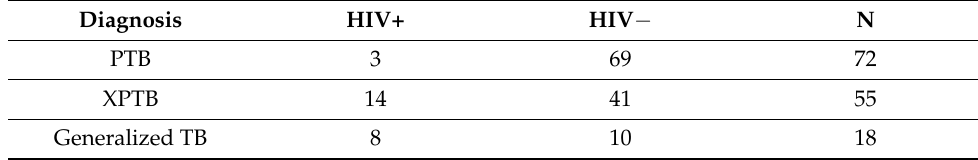
Table 4. Number of TB/HIV coinfection cases.